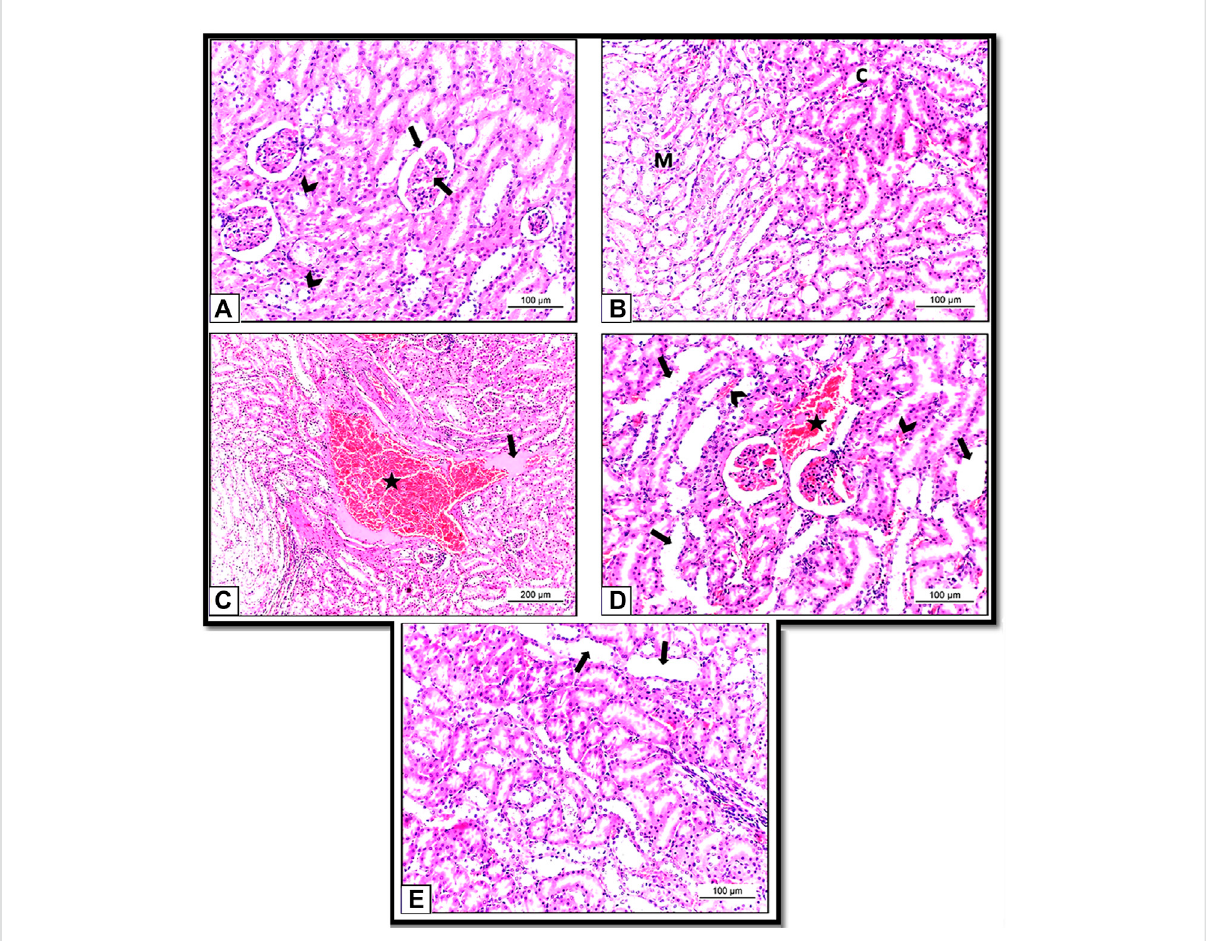
FIGURE 8 (A) :Sectionofalbinorat ’ skidneyofControlgroup(GroupI)showingnormalrenalarchitecturewithnormaltubules(arrowheads)andglomeruli (arrow). H&E X200. (B) : Section of albino rat ’ s kidney of HSP group (Group III) also showing normal renal architecture of renal tubules in both cortex (C) and medulla (M). H&E X 200. (C,D) : Sections of albino rats ’ kidney of NiO-NPs group (Group II). (C) : Showing blood vessels are dilated and engorged with blood (star). H&E X 100. (D) : Showing vacuolar degeneration of the hepatocytes (arrow heads). H&E X 200. (E) : Section of albino rat ’ s kidney of NiO-NPs + HSP group (Group IV) showing decreased tubular degeneration and congestion with few degenerated tubules (arrows). H&E X